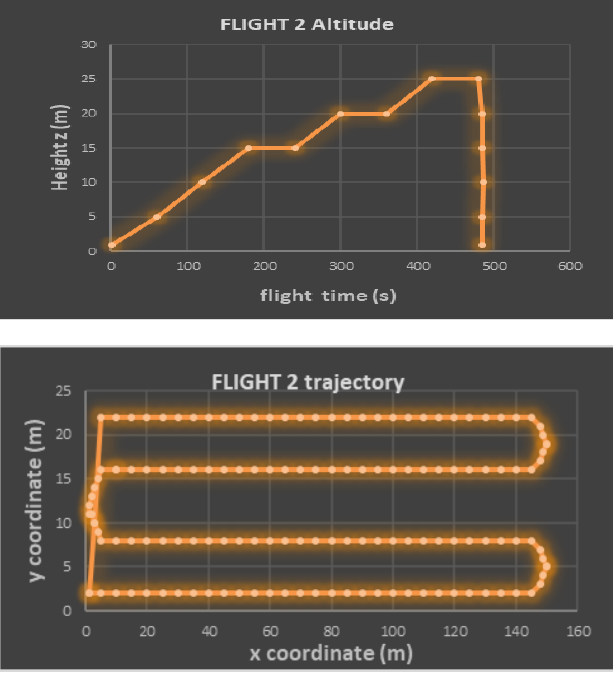
Figure 4. Altitude and planar projection of flight